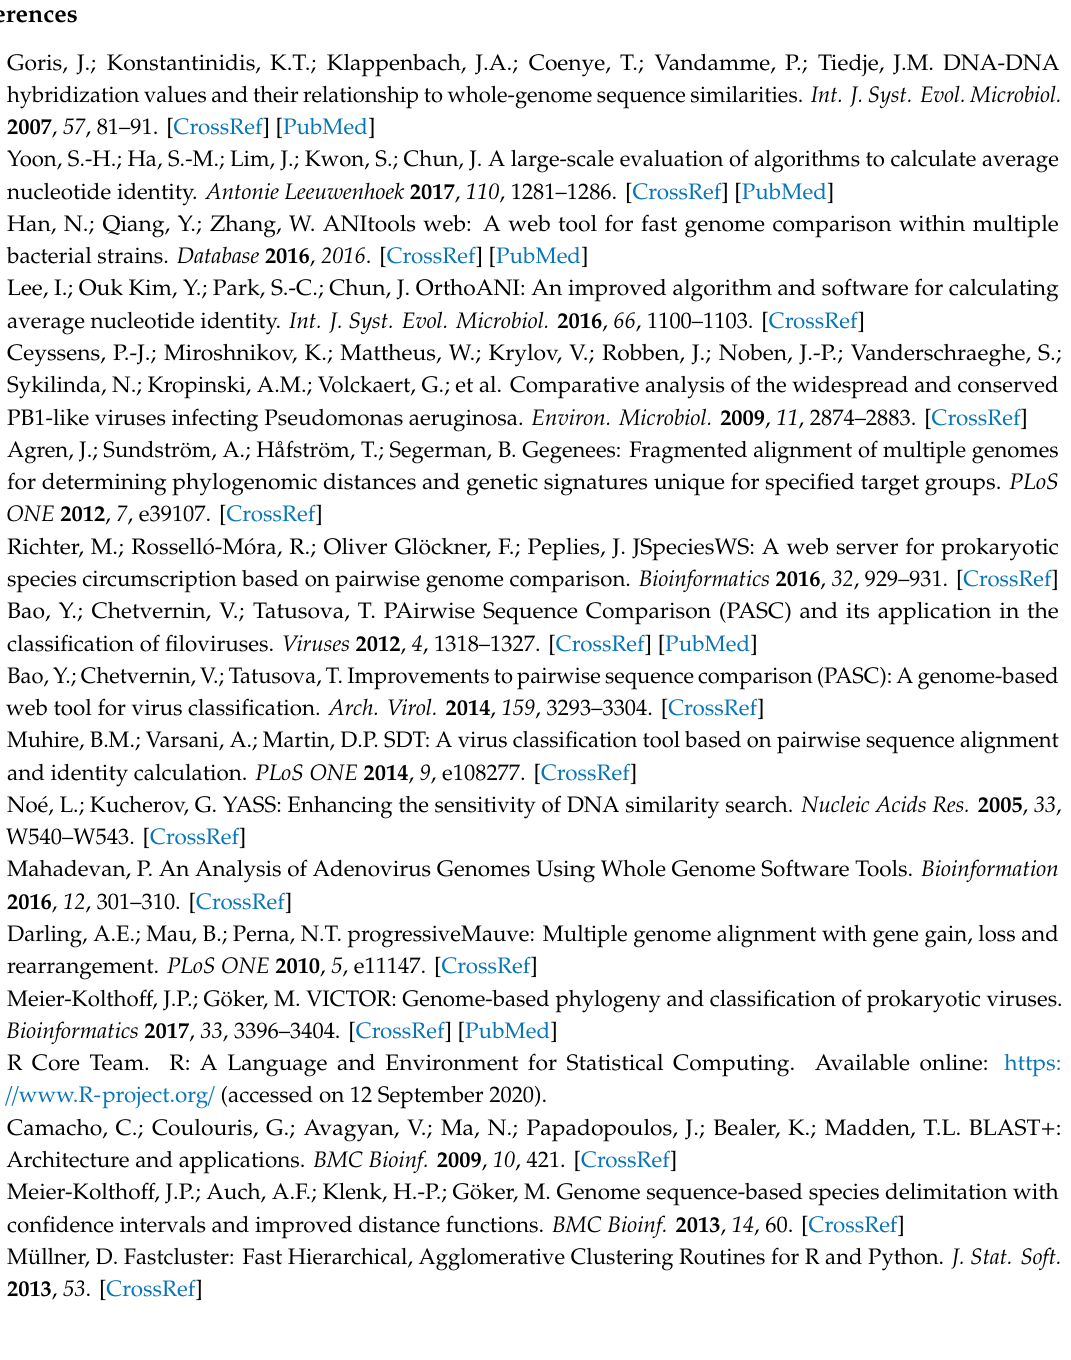
Table S1: the complete list of viral genomes used for benchmarking VIRIDIC, their genome properties and intergenomic similarity values produced by di ff erent